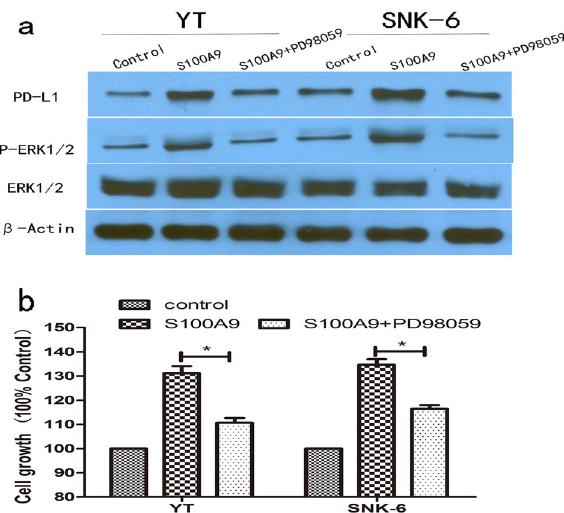
Figure 6. S100A9 induces PD-L1 expression and promotes cell proliferation via activation of ERK1/2 signaling in NKTCL cells. ( a ) ERK1/2 inhibitor (PD98059) decreased the upregulation of PD-L1 expression induced by S100A9. ( b ) ERK1/2 inhibitor (PD98059) also decreased cell proliferation promoted by S100A9 alone. * p <